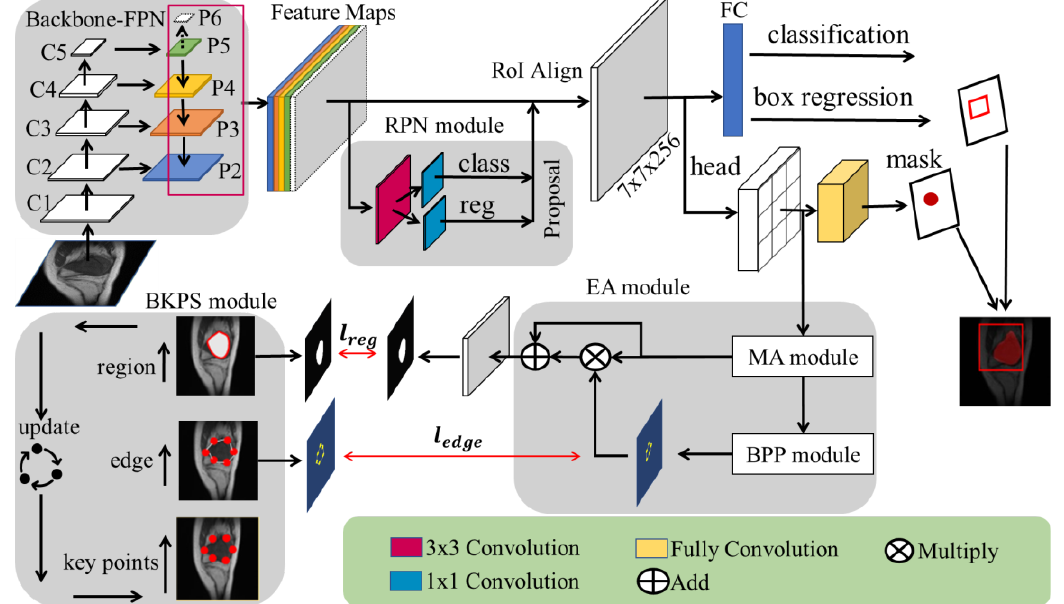
Figure 1. The architecture diagram of SEAGNET.